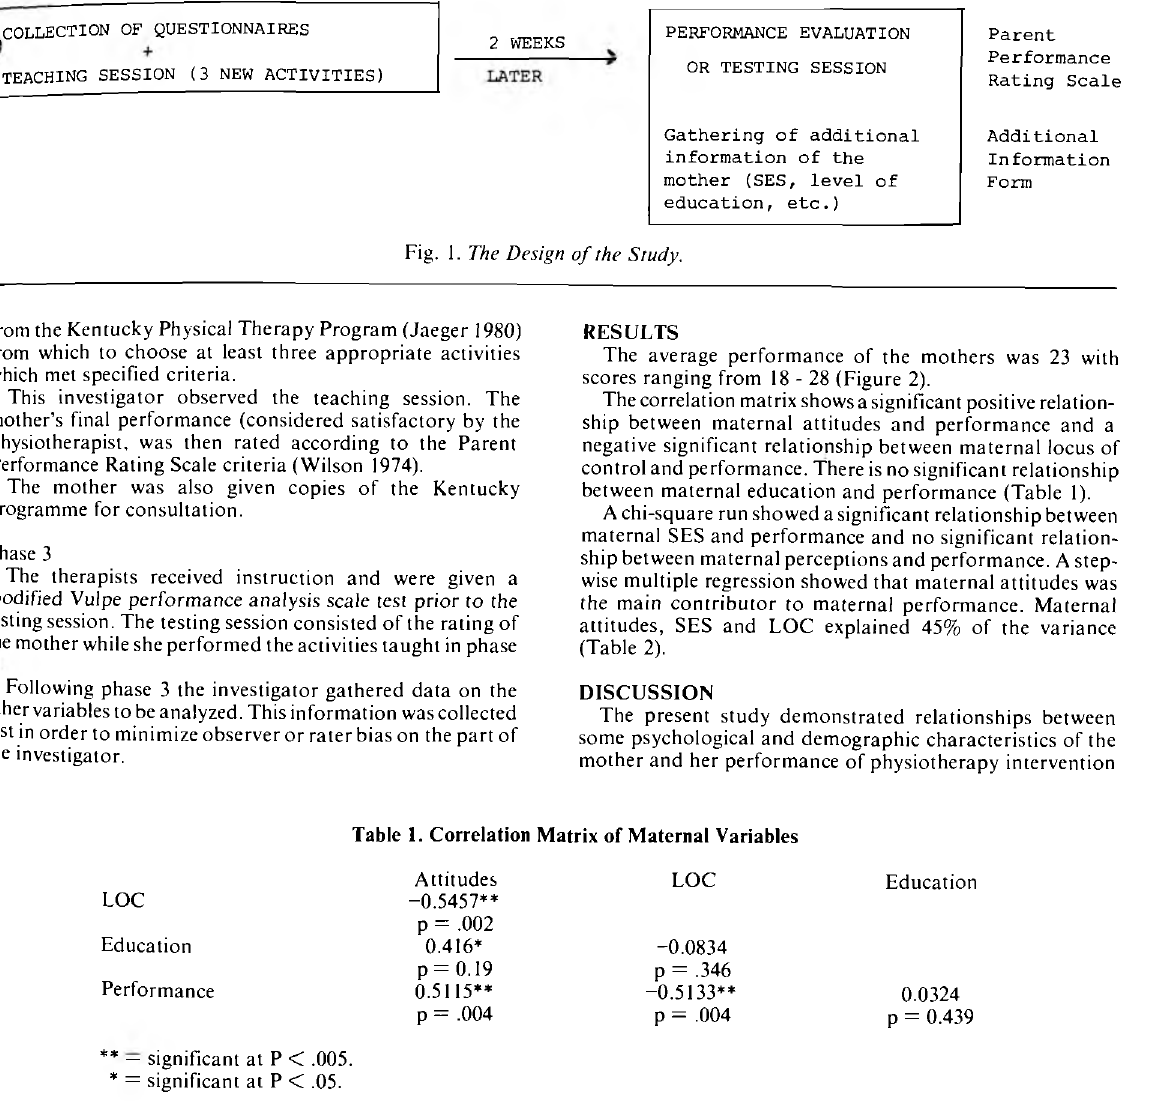
Table 1. Correlation Matrix of Maternal